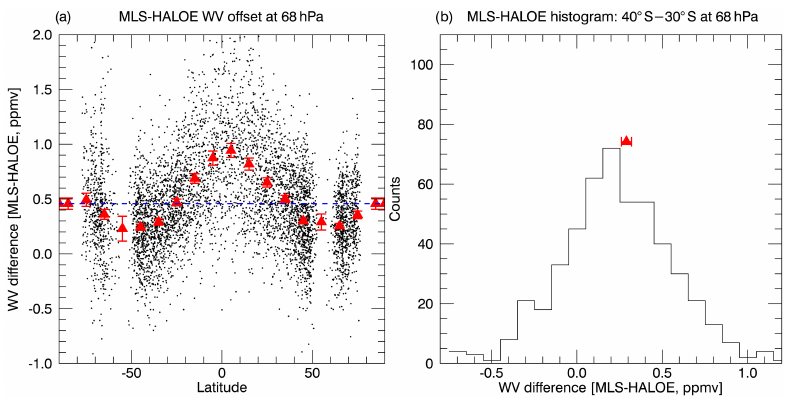
Figure 7. Example of WV offset adjustment for HALOE at 68hPa. (a) Matched MLS/HALOE pairs (dots), the 10 ◦ latitude binned means (red filled triangles) with error bars showing the offset uncertainties (95% confidence interval). The mean (over all latitudes) is shown as a horizontal blue dashed line. (b) The histogram of MLS/HALOE differences at 68hPa for the 40–30 ◦ S latitude bin. The offset uncertainty for this bin is shown as a horizontal red bar.